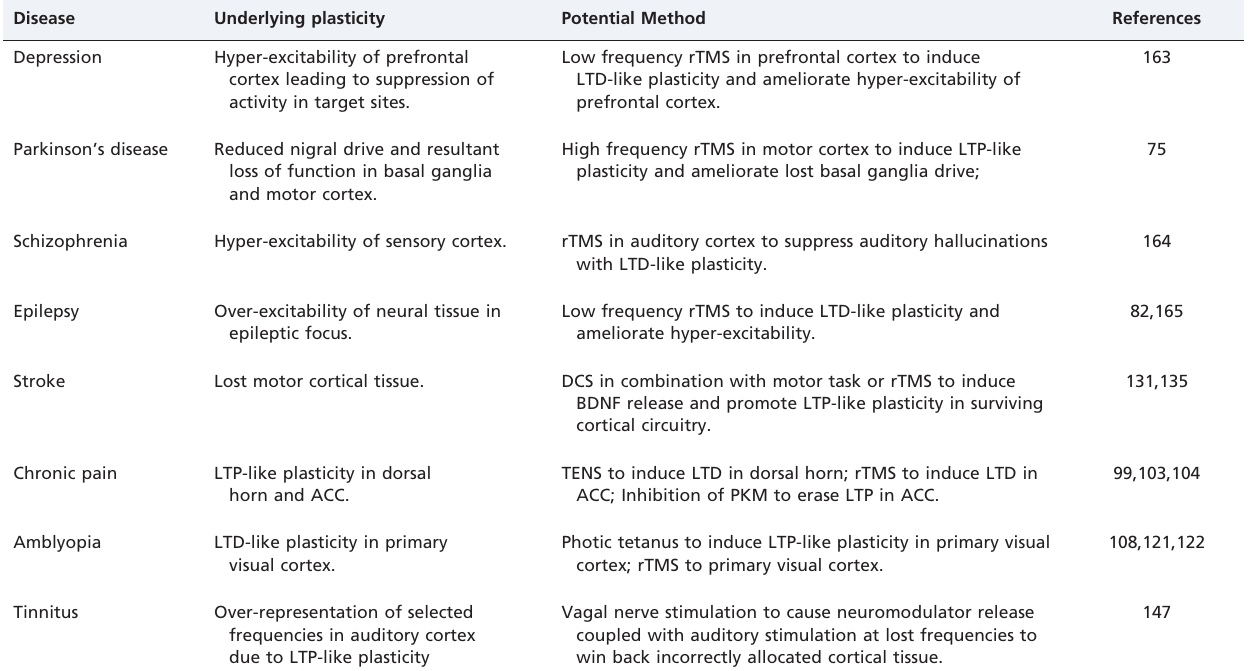
Table 1 - The potential applications of LTP/LTD-like plasticity to the treatment of neurological disorders.